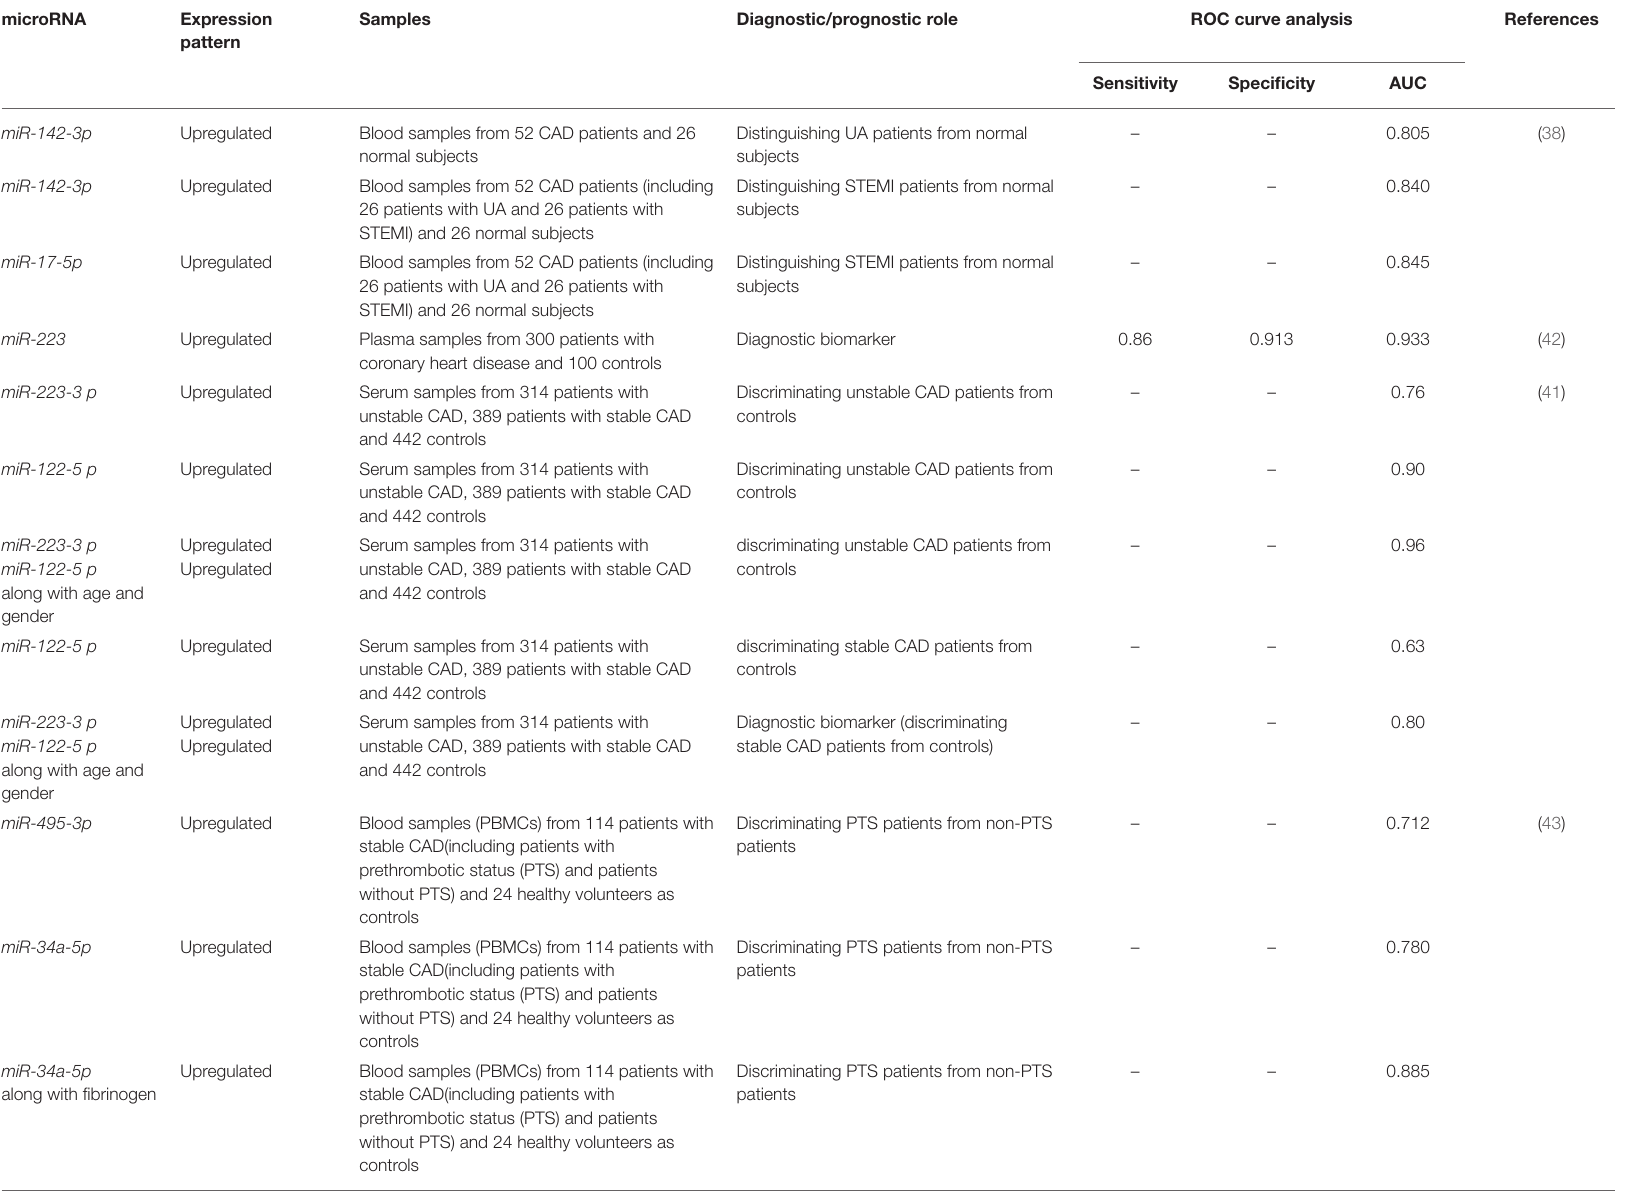
TABLE 4 | Diagnostic/prognostic significance of miRNAs in CAD (UA, unstable angina; STEMI: ST-segment elevation myocardial